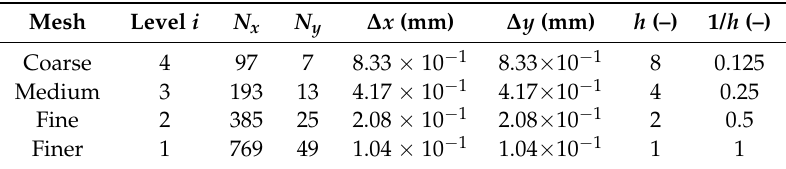
Table 3. Grid levels adopted in the mesh refinement